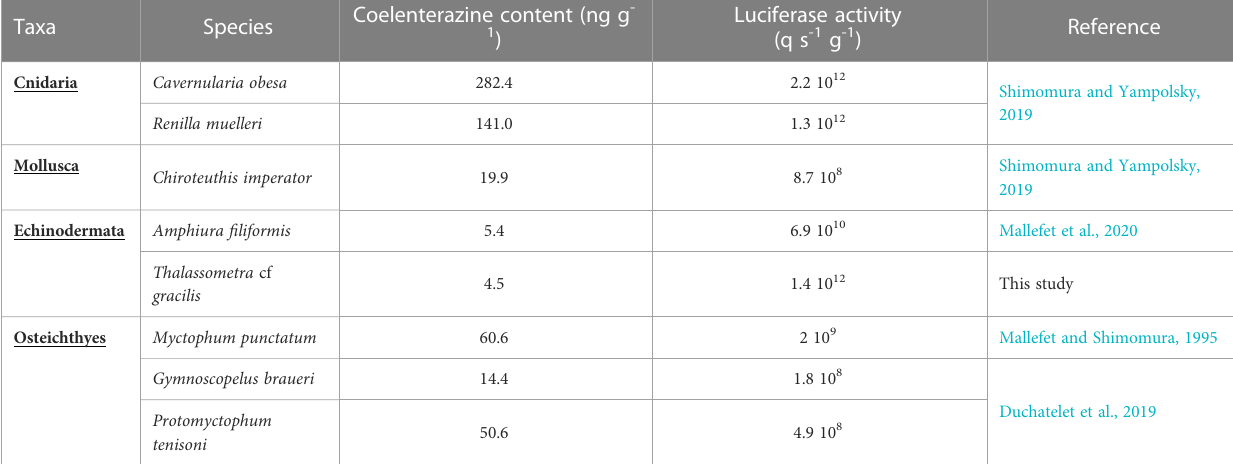
TABLE 1 C OELENTERAZINE CONTENT AND LUCIFERASE ACTIVITY FOR DIFFERENT MARINE SPECIES FROM DIFFERENT T AXA . D ATA ARE NORMALIZED PER GRAM OF TISSUE .